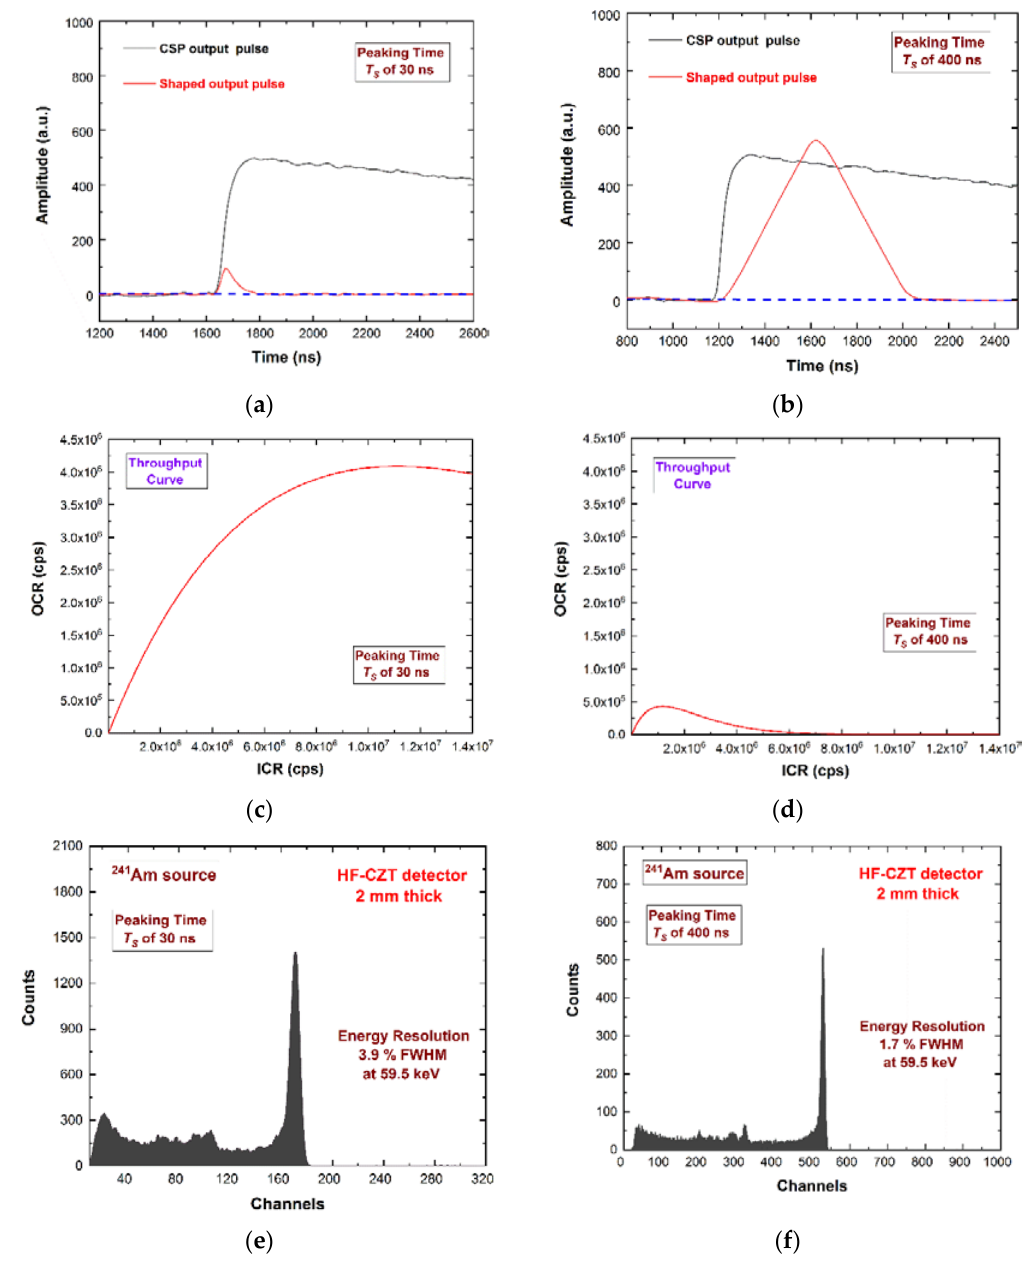
Figure 6. The preamplifier output pulses (black lines) and the shaped output pulses (red lines) with peaking times T S of ( a ) 30 ns ( ballistic deficit pulse processing ) and ( b ) 400 ns ( energy resolution pulse processing ). The calculated throughput curves, i.e., the output counting rate (OCR) vs. the input counting rate (ICR), with T S of ( c ) 30 ns and ( d ) 400 ns. The throughput curves were calculated considering paralyzable dead times (the full-time width of the shaped pulses over the threshold) of 90 ns and 850 ns for T S = 30 ns and 400 ns, respectively. The measured 241 Am energy spectra with T S equal to ( e ) 30 ns and ( f ) 400 ns. To optimize the binning of the pulse heights of the shaped pulses at T S of 30 ns, we used an amplitude gain equal to 2. We used two different pulse shaping set-ups: the first with a T S of 30 ns selected for high throughput (ballistic deficit pulse processing), the second with a T S of 400 ns for the best energy resolution (energy resolution pulse processing). The mean value of the time